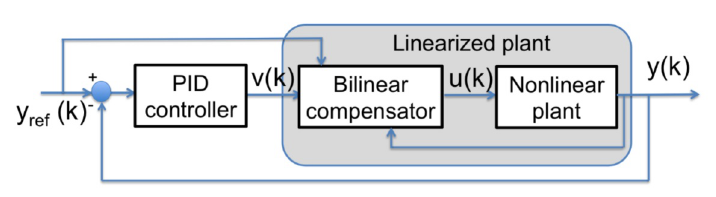
Figure 4. BPID controller scheme BPID control scheme [8] (taken and adapted from [21]). y ref ( k ) is the reference, y ( k ) is the position sensor signal, v ( k ) is the control signal generated by the PID controller and the u ( k ) is the control signal rectified by the bilinear